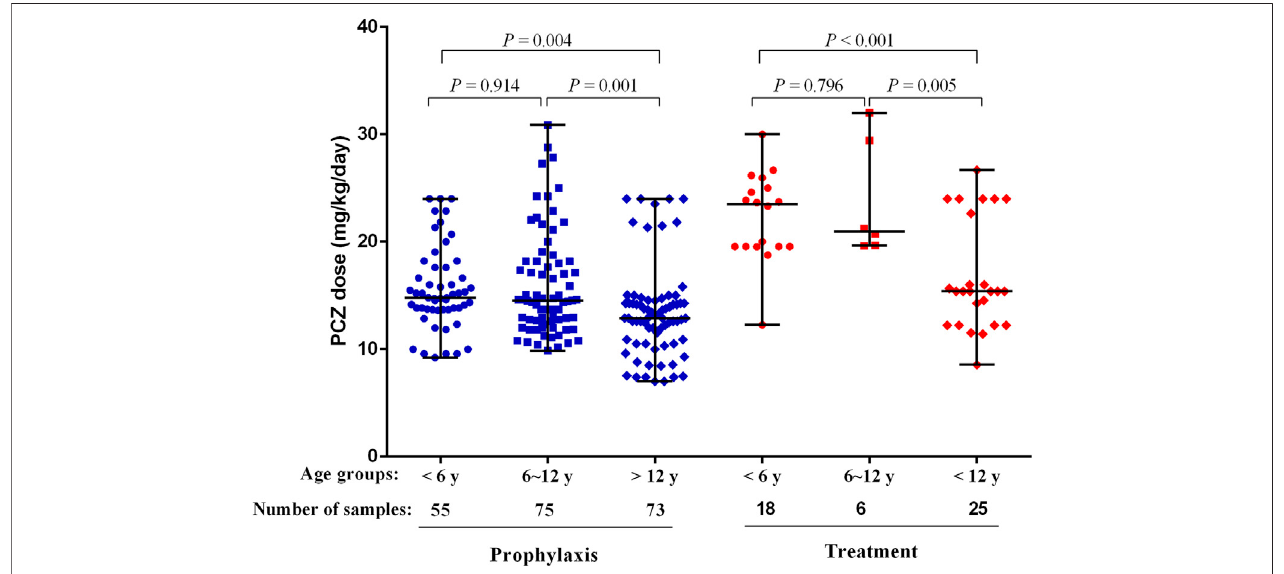
FIGURE 4 | PCZ maintenance dose required to achieve therapeutic Cmin for different age and the indication of treatment. Horizontal bars represent the median dose values for each group. y, years.